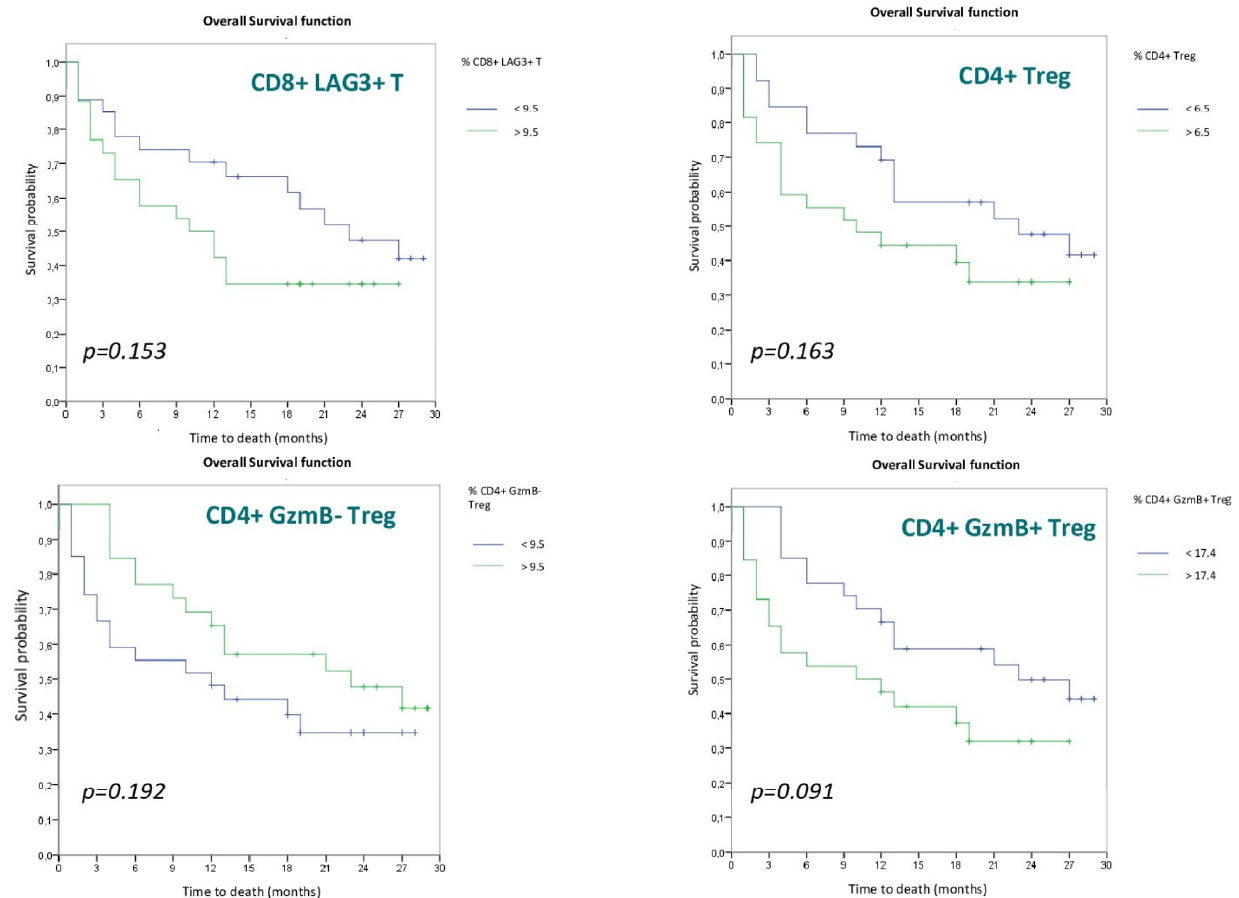
Figure 3. Overall survival curves according to Lymphocyte